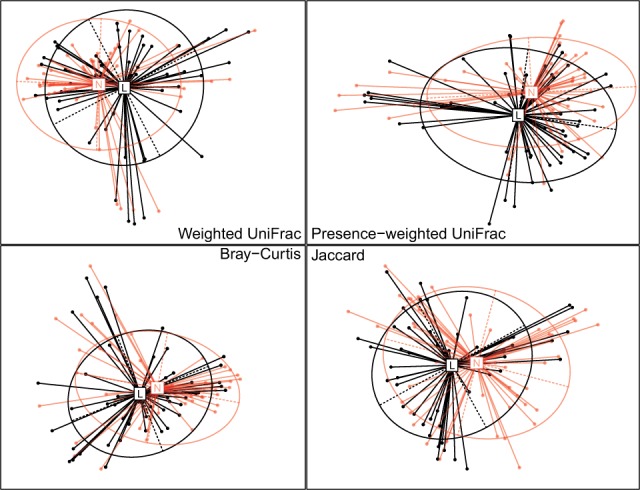
Comparison of abundance distances and presence–absence distances for discriminating lesion (L) and normal (N) samples. Principle component analysis is performed on the four distance matrices. The samples are plotted on the first two principle components. The ellipse center indicates groups means, and the height and width represent the variances on the two directions